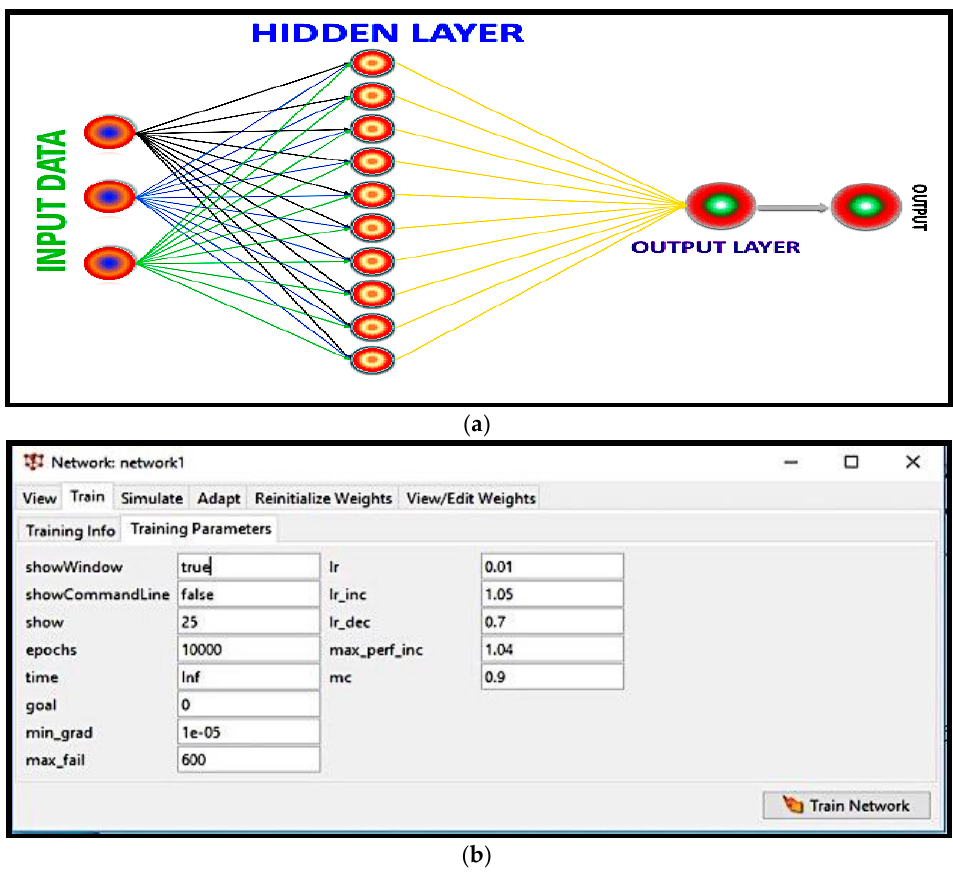
Figure 1. ANN model ( a ) architecture view and ( b ) training parameters. Table 1. ANN parameters for the indicated model.